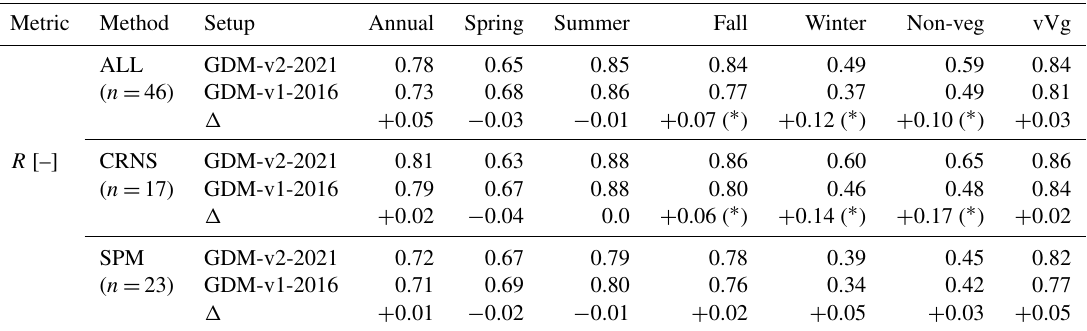
Table 3. Median Spearman rank correlation coefficients R of simulated (GDM-v1-2016, GDM-v2-2021) versus observed deseasonal- ized SM anomalies at depth 0–25cm. The correlation coefficients are calculated annually, seasonally (spring = March, April, May; sum- mer = June, July, August; fall = September, October, November; winter = December, January, February) and over the vegetative and non- vegetative active periods (defined as April–October and November–March, respectively). Note that some of the 40 locations have multiple SM data sources available, resulting in n = 46; see Table 2. ∗ denoting significant differences ( p -value < 0.05) in correlations between the model setups according to the paired Wilcoxon signed rank